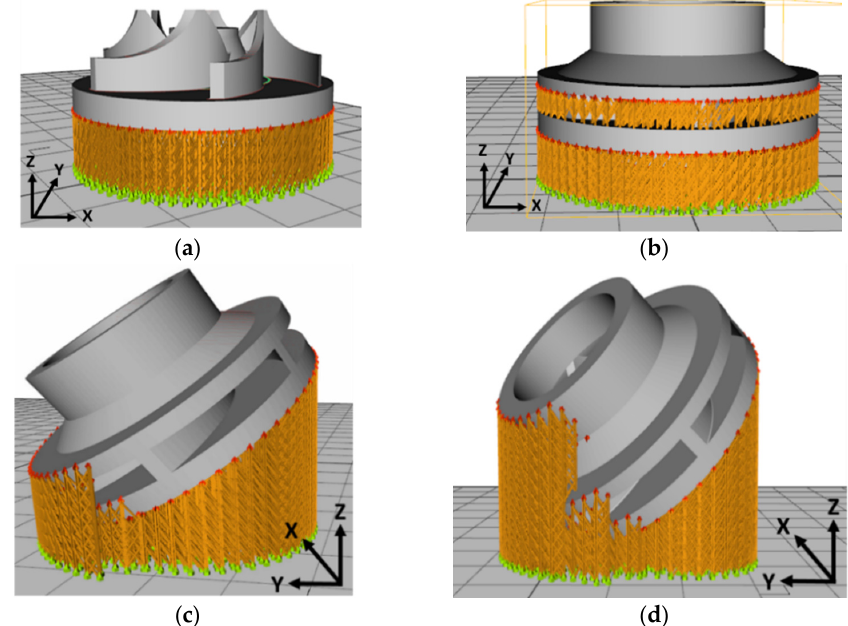
Figure 4. Building direction and support structure for the open and closed impeller models: ( a ) open impeller—built at orientation of Z axis (building direction); ( b ) closed impeller—built at orientation of Z axis (building direction); ( c ) closed impeller—built in orientation B + 32° (angled 32°); ( d ) closed impeller—built at orientation B + 45° (angled 45°).